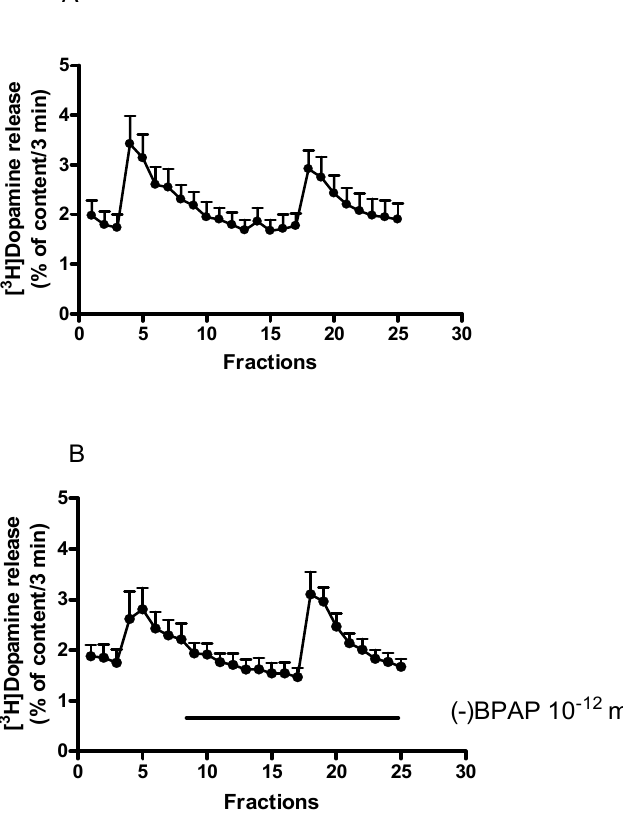
Figure 5. ( − )BPAP increased electrical stimulation-induced [ 3 H]dopamine release from rat striatum. of 10 − 12 mol/L to the superfusion buffer from fraction 8 and maintained throughout the